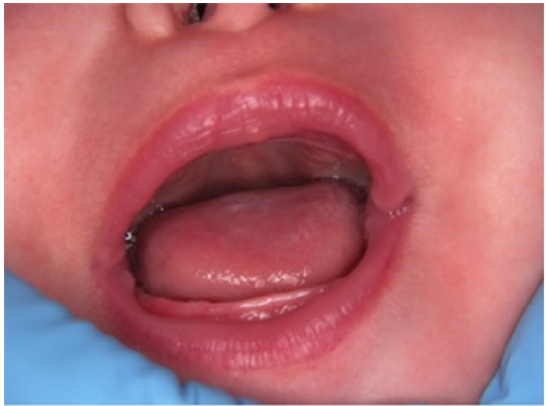
Fig. 1. Bilateral commissural pits without fl